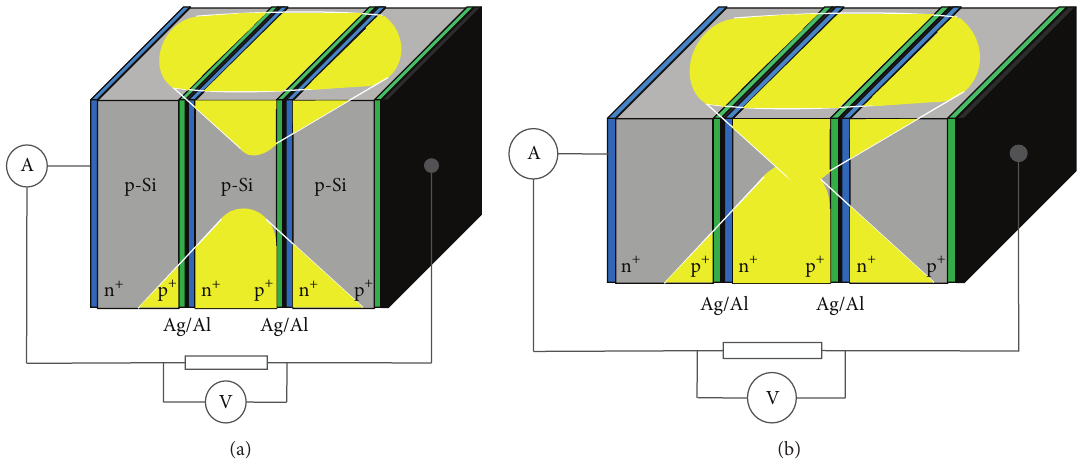
Figure 8: Model of multidiode solar cell module with vertically aligned p-n junctions. (a) initial; (b) after RIE and RF treatments. Light propagation regions are given in